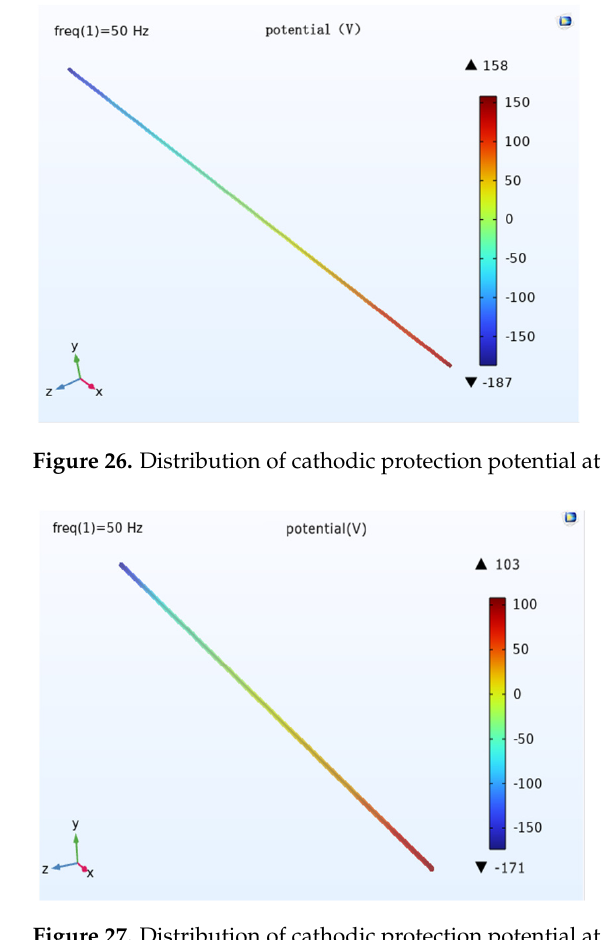
Figure 25. Distribution of cathodic protection potential at 2 m burial depth.